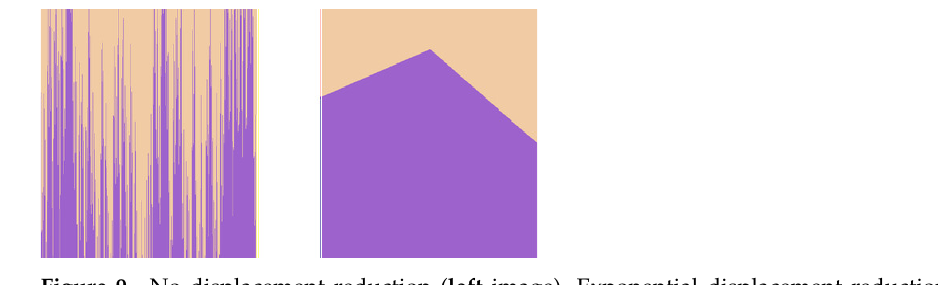
Figure 9. No displacement reduction ( left image), Exponential displacement reduction in one iteration ( right image). (Image source: https://bitesofcode.wordpress.com/2016/12/23/landscape- generation-using-midpoint-displacement/, accessed on 22 June 202).